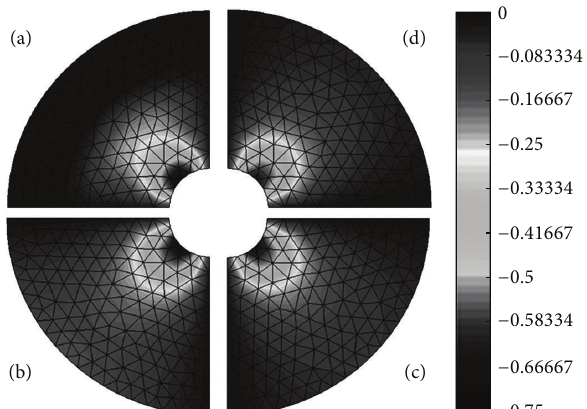
Figure 14: Spatial and temporal evolution of 𝜎 𝑥𝑦 considering elastoplastic analysis (scale factor: 6.8947 ⋅ 10 6 N / m 2 ); (a) 𝑡 = 4 s; (b) 𝑡 = 8 s; (c) 𝑡 = 12 s; (d) 𝑡 = 16 s.